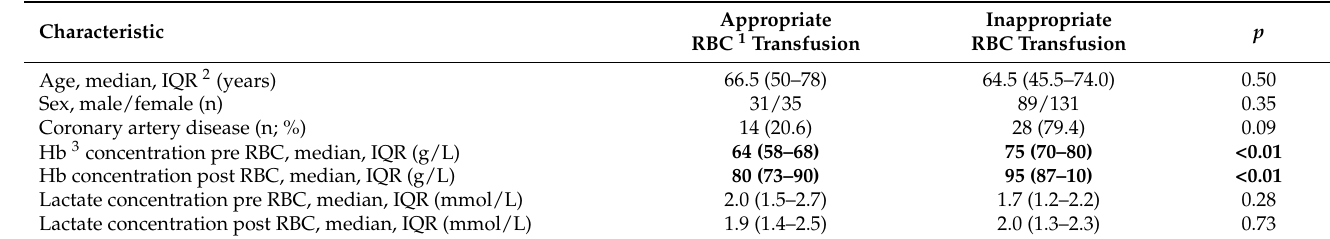
Table 5. Characteristics of recipients of appropriate and inappropriate RBC